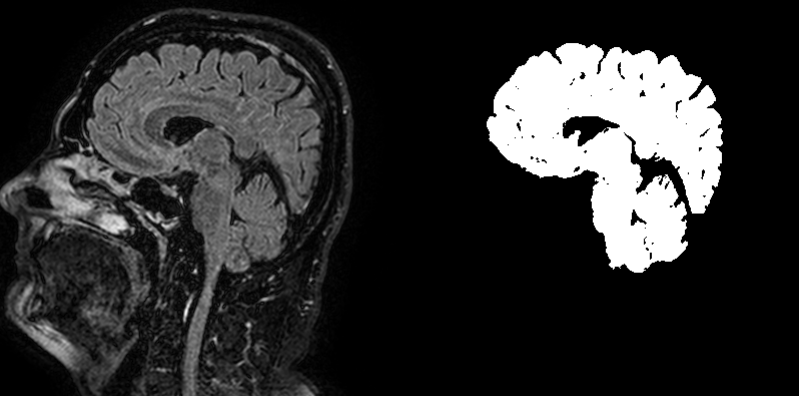
Figure 2. Example of brain dataset sagittal image slice ( left ) and according ground truth mask ( right